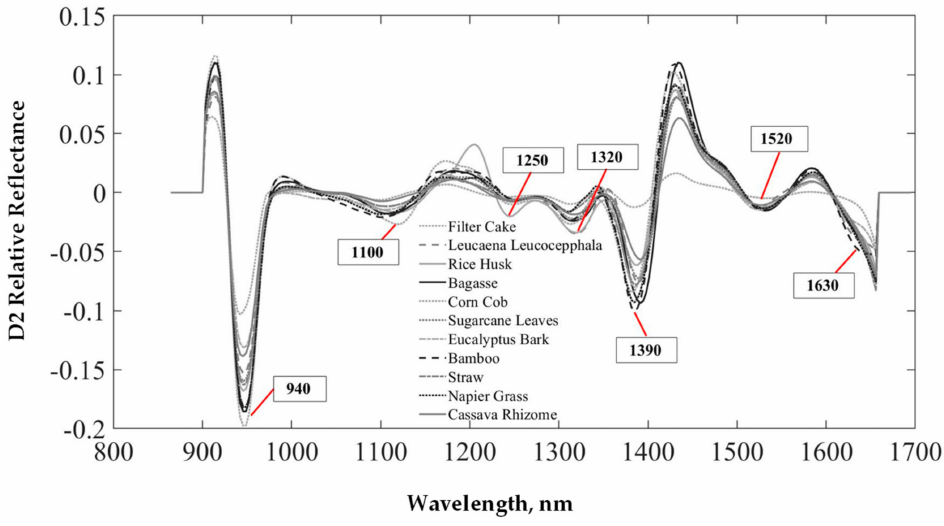
Figure 4. Average spectra from 11 types of the second derivative of various biomass